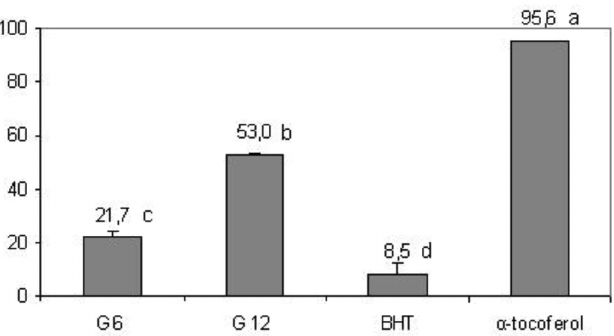
FIGURE 3 - Free radical-scavenging activity on DPPH of the α-tocopherol, BHT and ethanolic extracts of G6 and G12 propolis. Means (n=3) followed by different letters are significant at 5% (Tukey test p<0